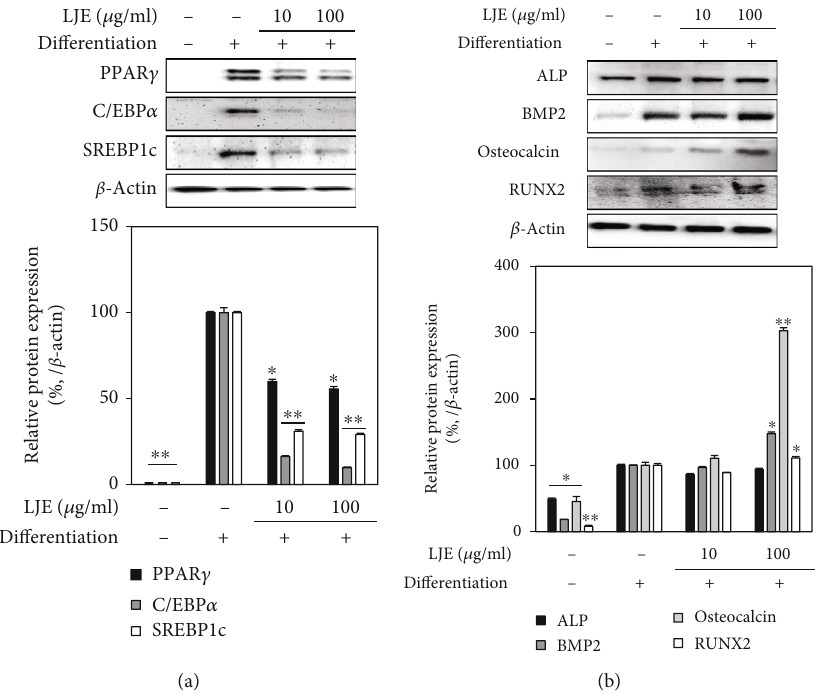
Figure 3: E ff ect of LJE on protein expression of (a) adipogenic and (b) osteogenic markers and transcription factors. Analysis of protein levels was carried out by Western blotting using the di ff erentiated hBM-MSC lysates with or without LJE treatment (10 and 100 μ g/ml). Western blot bands were densitometrically quanti fi ed and plotted as relative percentage of the untreated di ff erentiated control group. β -Actin was used as internal loading control and the expression. ∗ p < 0 : 05 and ∗∗ p < 0 : 01 vs. the untreated di ff erentiated control